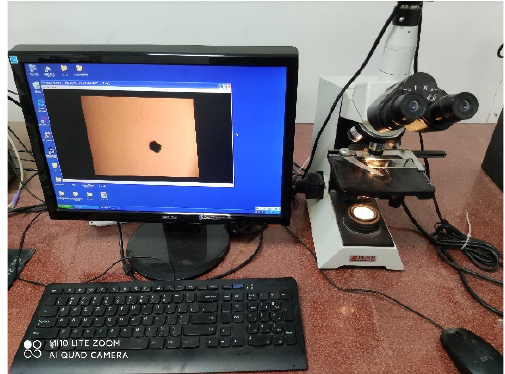
Figure 2. XS-2100 image particle analyzer.